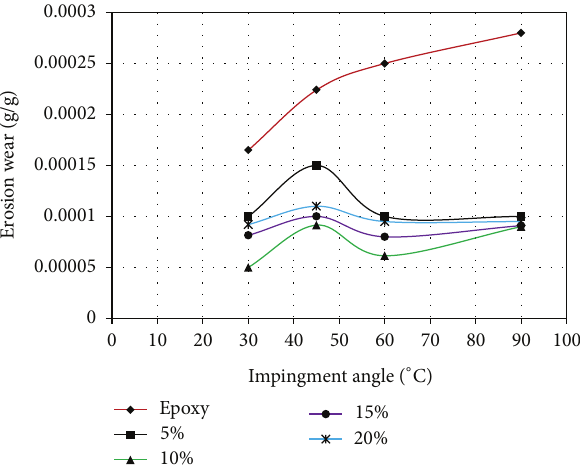
Figure 6: Variation of the storage modulus with the temperature for the pure epoxy and the composites reinforced with different volume fractions of wood apple shell particles.